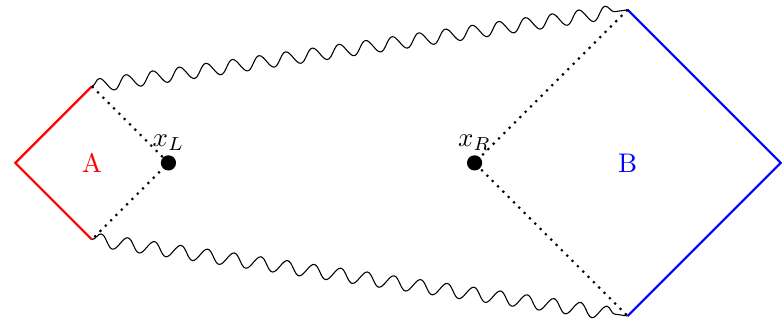
Figure 7 . The Penrose diagram of the glued spacetime A/B with two different black hole masses in CGHS